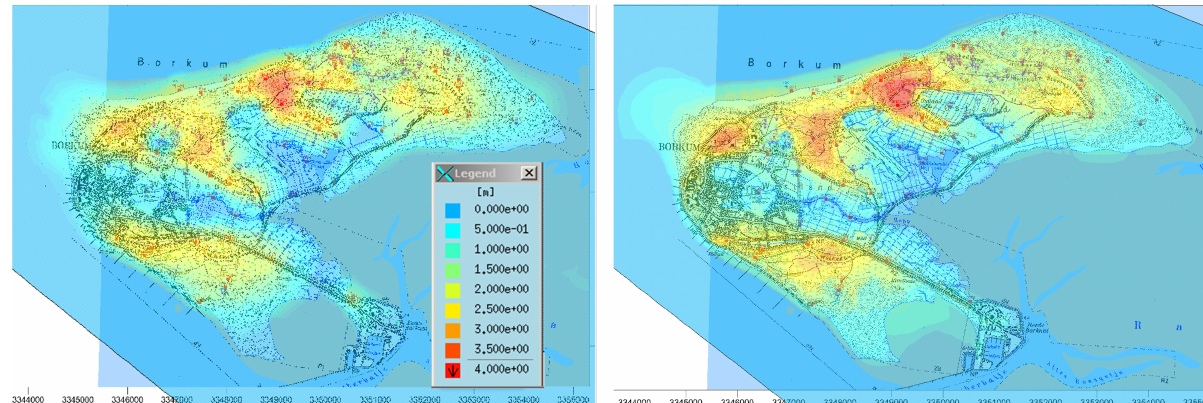
Fig. 11. Direct comparison of measured (left panel) with computed hydraulic heads (right panel).